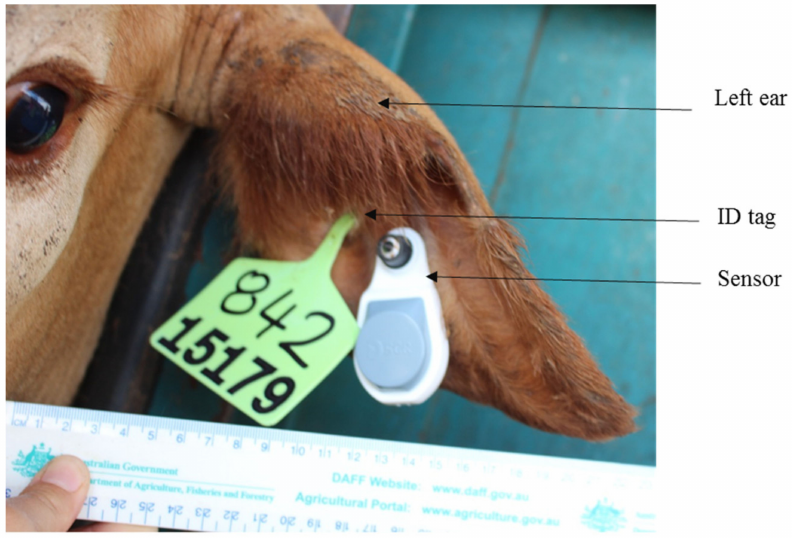
Figure 1. Installation of ear tag